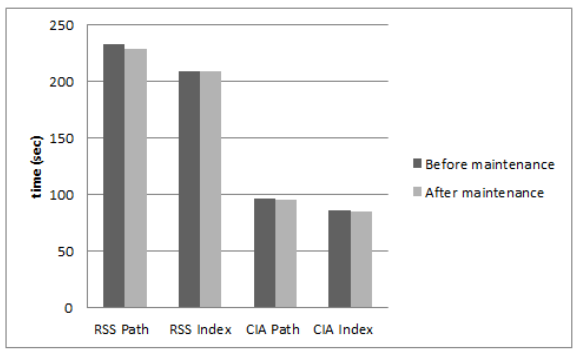
Fig. 6. Xindice Experiment Computation Breakdown